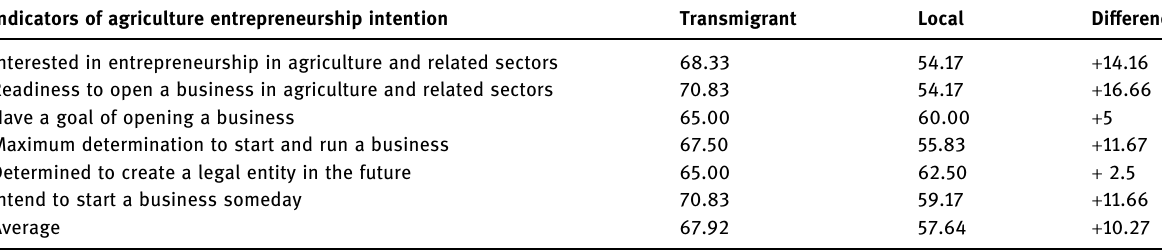
Indicators of agriculture entrepreneurship